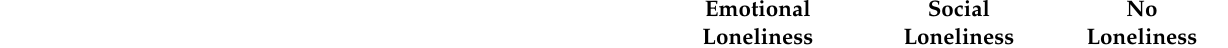
Table 5. Coding of Items of the Differential Loneliness Scale